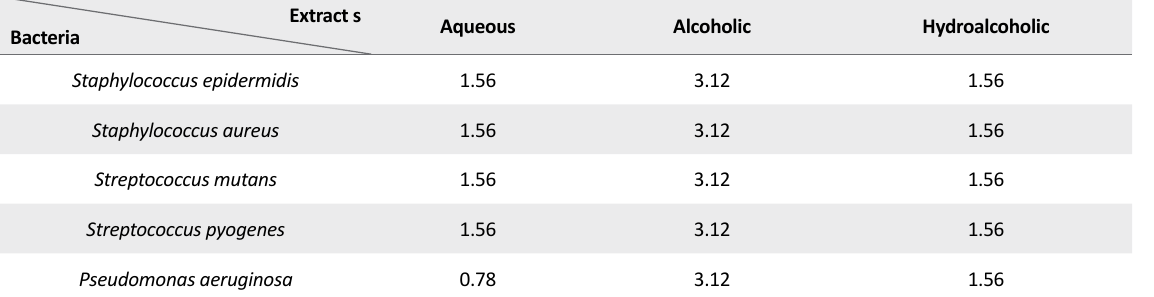
Table 2. MIC (mg/mL) of different extracts of Morus nigra fruit against the tested bacteria Extract s Bacteria